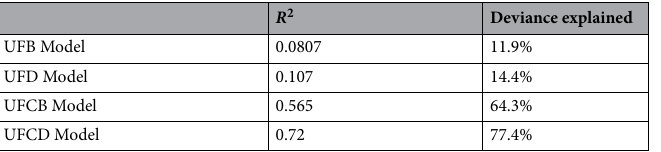
2 Table 1. Model evaluation. R values of 0.0807, 0.107, 0.565 and 0.72 and deviance explained percentages of 11.9%, 14.4%, 64.3% and 77.4% of UFB, UFD, UFCB and UFCD Models are revealed. Values of R deviance explained percentages of UFCB and UFCD Models are much higher than those of UFB and UFD